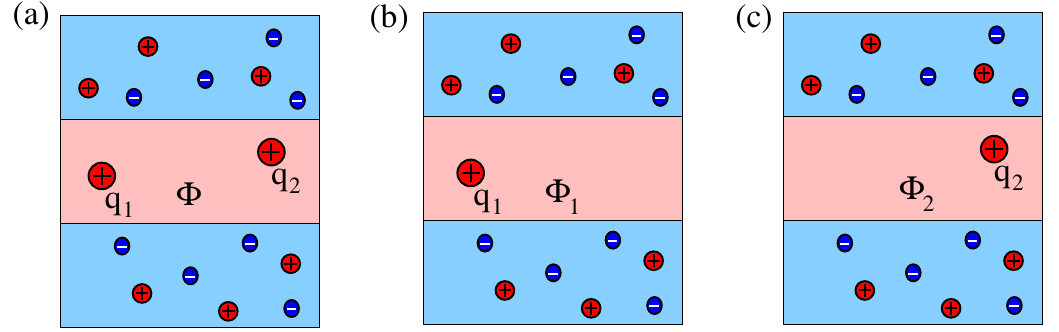
Figure A2. Diagram ( a ) Two point charges, q 1 and q 2 located inside a lipid membrane produce an electrostatic potential Φ . Diagram ( b ) We remove the charge q 2 and denote the potential due to the presence of the remaining charge q 1 by Φ 1 . Diagram ( c ) We remove the charge q 1 and denote the potential due to the presence of the remaining charge q 2 by Φ 2